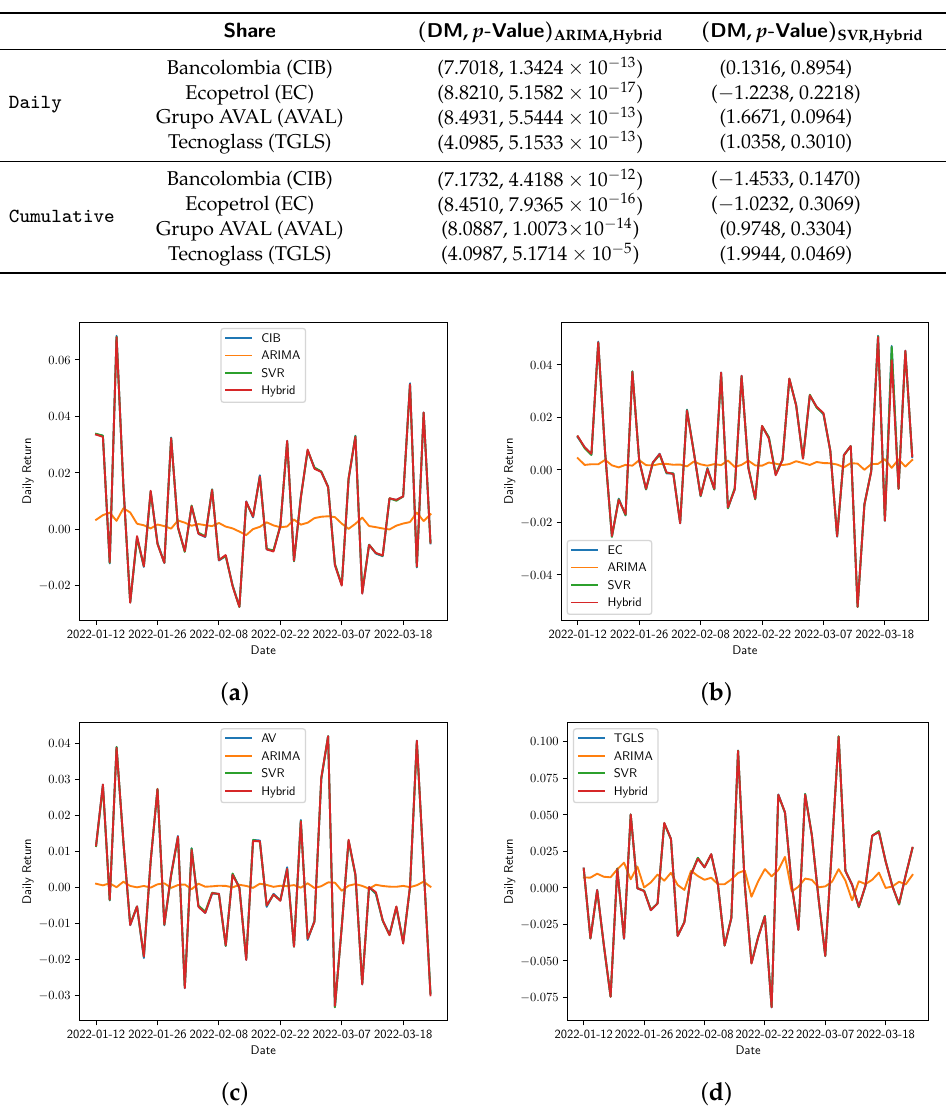
Figure 9. Real vs. the ARIMA, SVR, and Hybrid models’ adjustment for daily returns. ( a ) Bancolom- bia, ( b ) Ecopetrol, ( c ) Grupo AVAL, and ( d ) Tecnoglass. The real-time series is represented by the stock symbol and its forecasts by the name of the corresponding